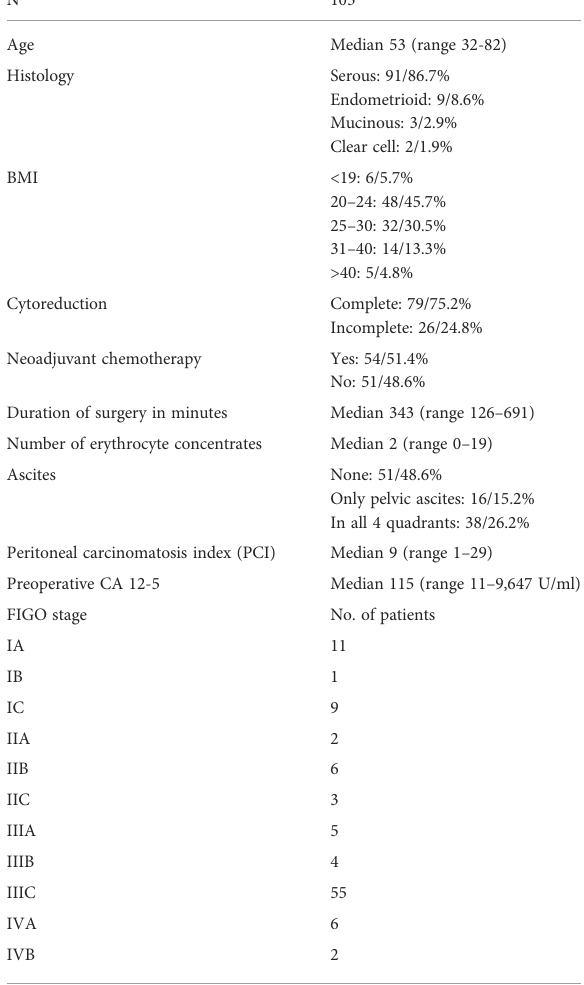
TABLE 1 General patient